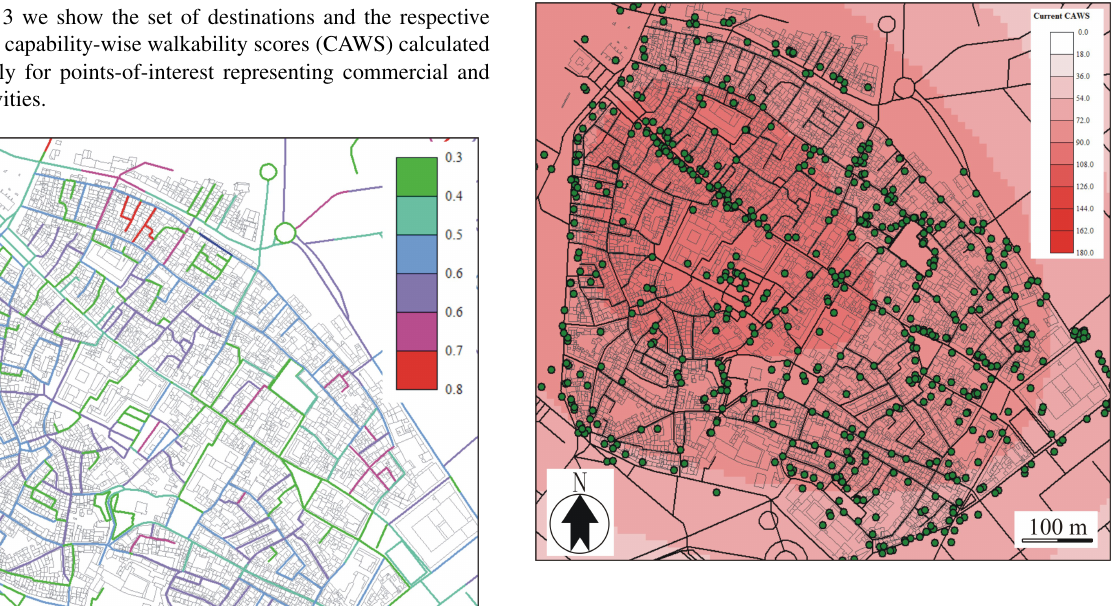
Figure 3. Status quo capability-wise walkability scores (CAWS) for points-of-interest representing commercial and retail